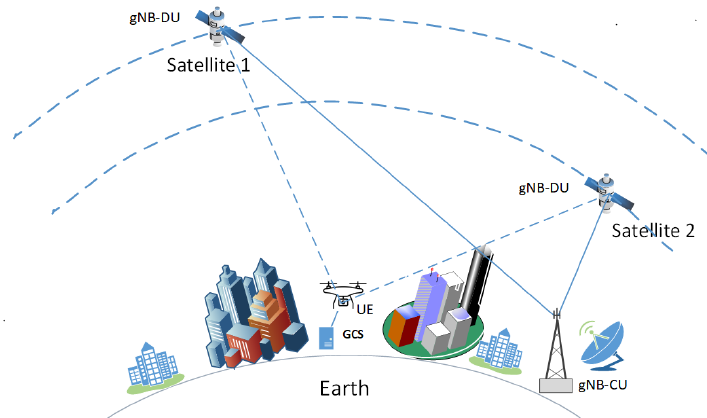
Figure 1. Reference scenario: a UE (UAV) accessing two satellites in an NTN in a dense urban